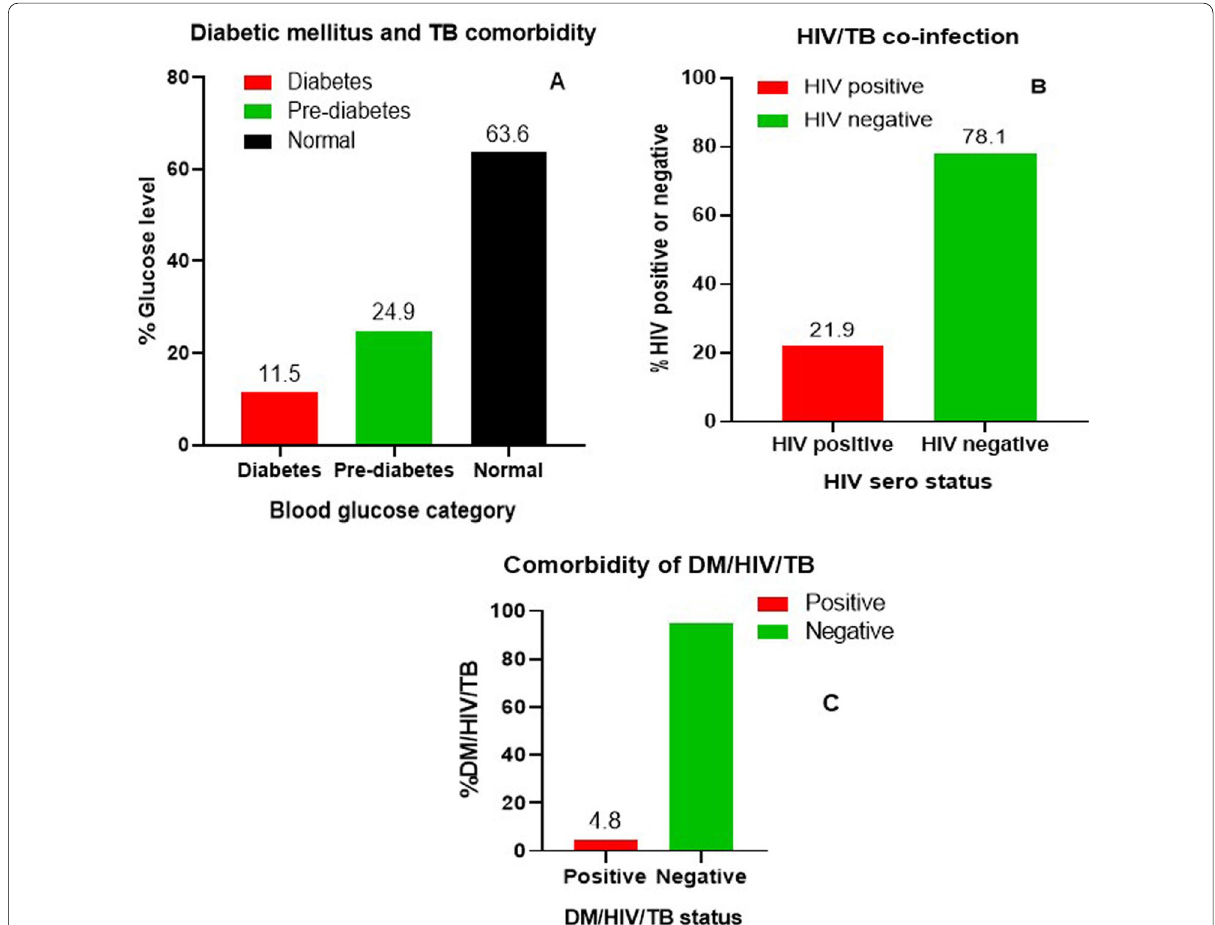
Fig. 2 Prevalence of diabetes mellitus and HIV among TB patients. A Fasting plasma glucose level; B HIV–TB co-infection and C the triplets’ comorbidity (DM/HIV/TB) among TB patients. DM diabetes mellitus, TB tuberculosis, HIV human immunodeficiency